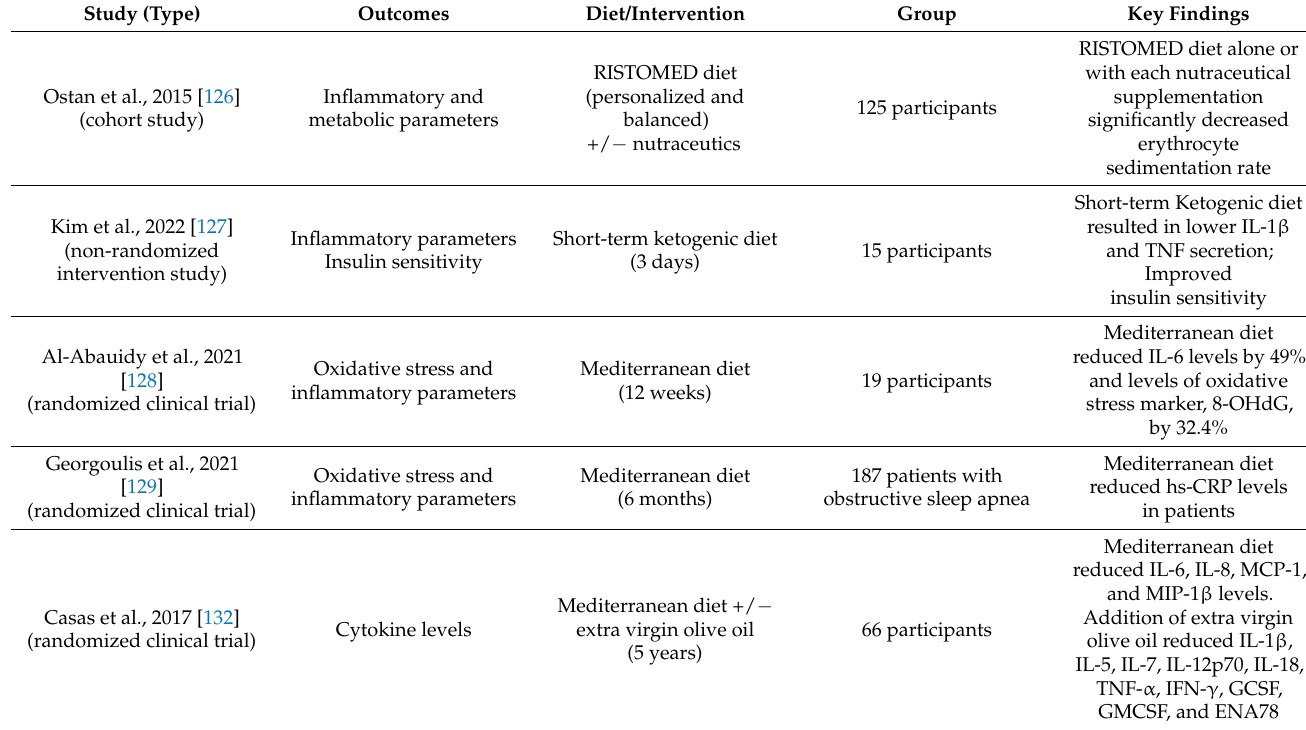
Table 1. Summary of findings associated with diet and